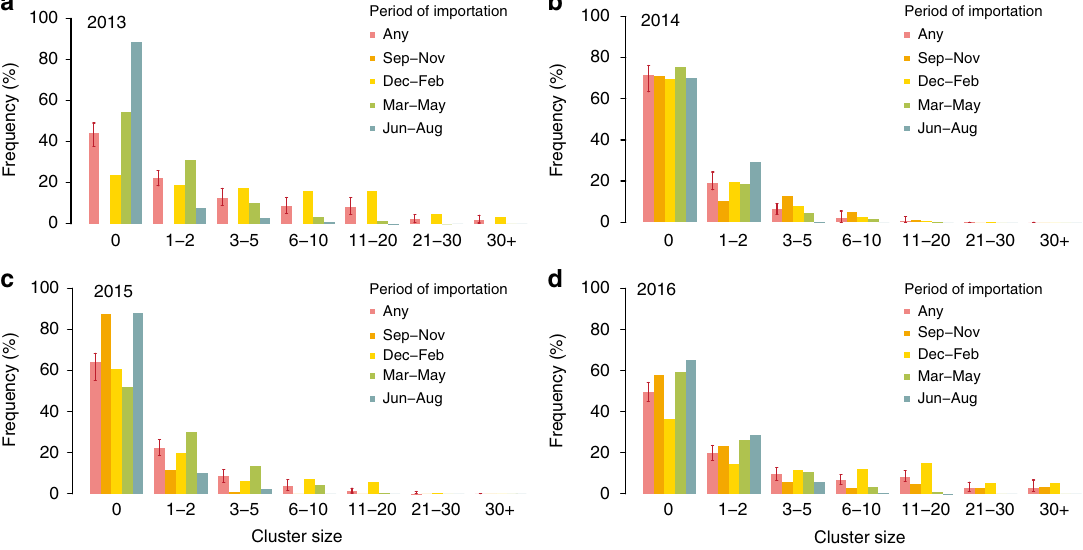
Fig. 3 Cluster size distribution by year and period of importation. Distribution of cluster size by year (and 95%CI) as resulting from the analysis of all transmission clusters, or by considering clusters seeded in different time periods. Index cases are not considered in the computation of the cluster size. Different panels ( a - d ) refer to different epidemiological years